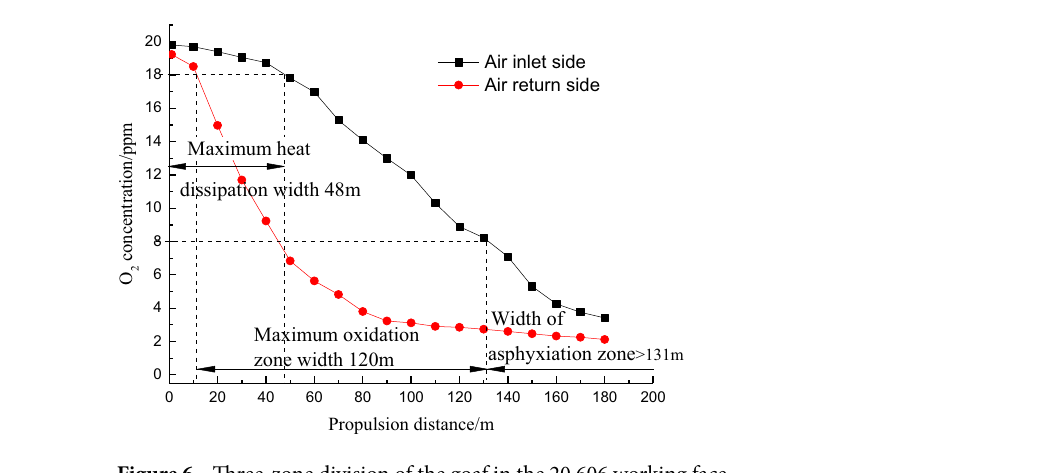
Figure 6. Three-zone division of the goaf in the 20,606 working